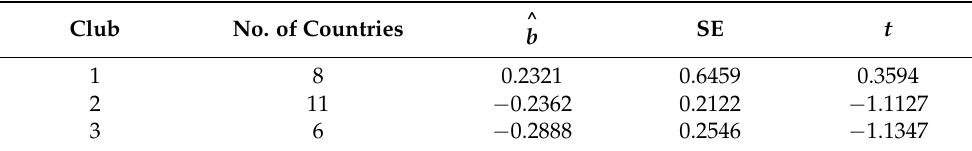
Table 1. Summary results for the log t